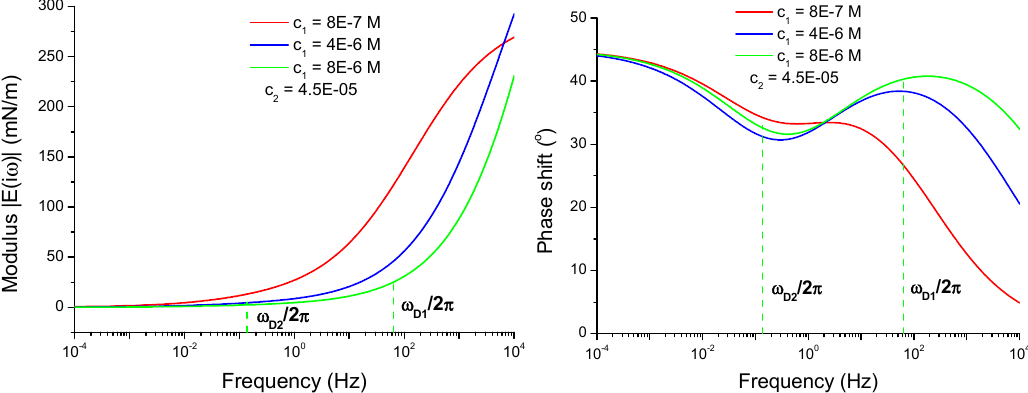
( ) ω iE and phase shift φ ( ω ) of a mixed adsorption layer as = 8.0 × 10 − 7 , 4.0 × 10 − 6 1 = α c 8.0 × 10 − 7 , = 4.5 × 10 − 5 mol/dm 3 1 2 = α c 4.5 × 10 − 5 mol/dm 3 . 2